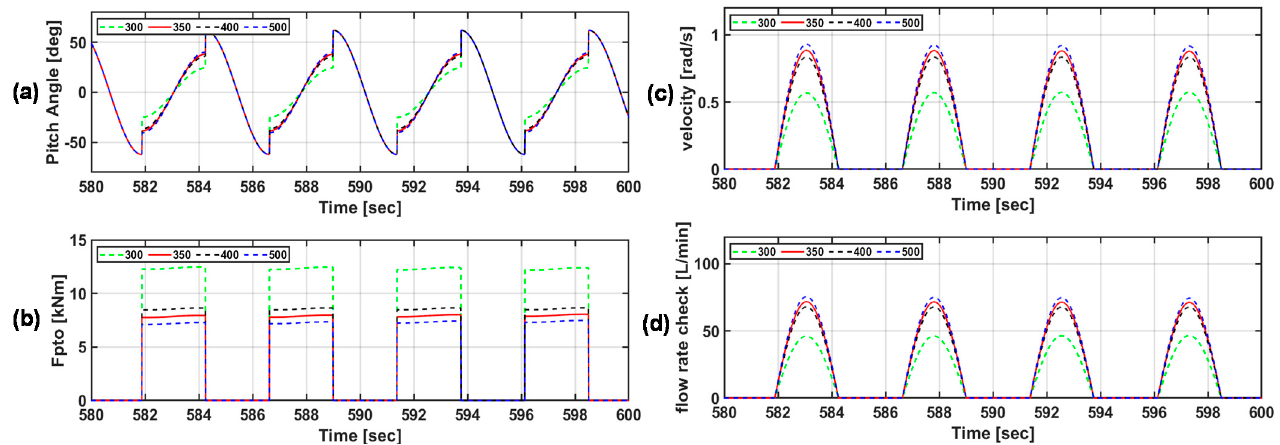
Figure 10. ( a ) Floating body motion, ( b ) PTO force, ( c ) floating body speed, and ( d ) generated flow rate according to the initial reference rpm of the speed control algorithm under regular wave conditions (legend indicates initial rpm).